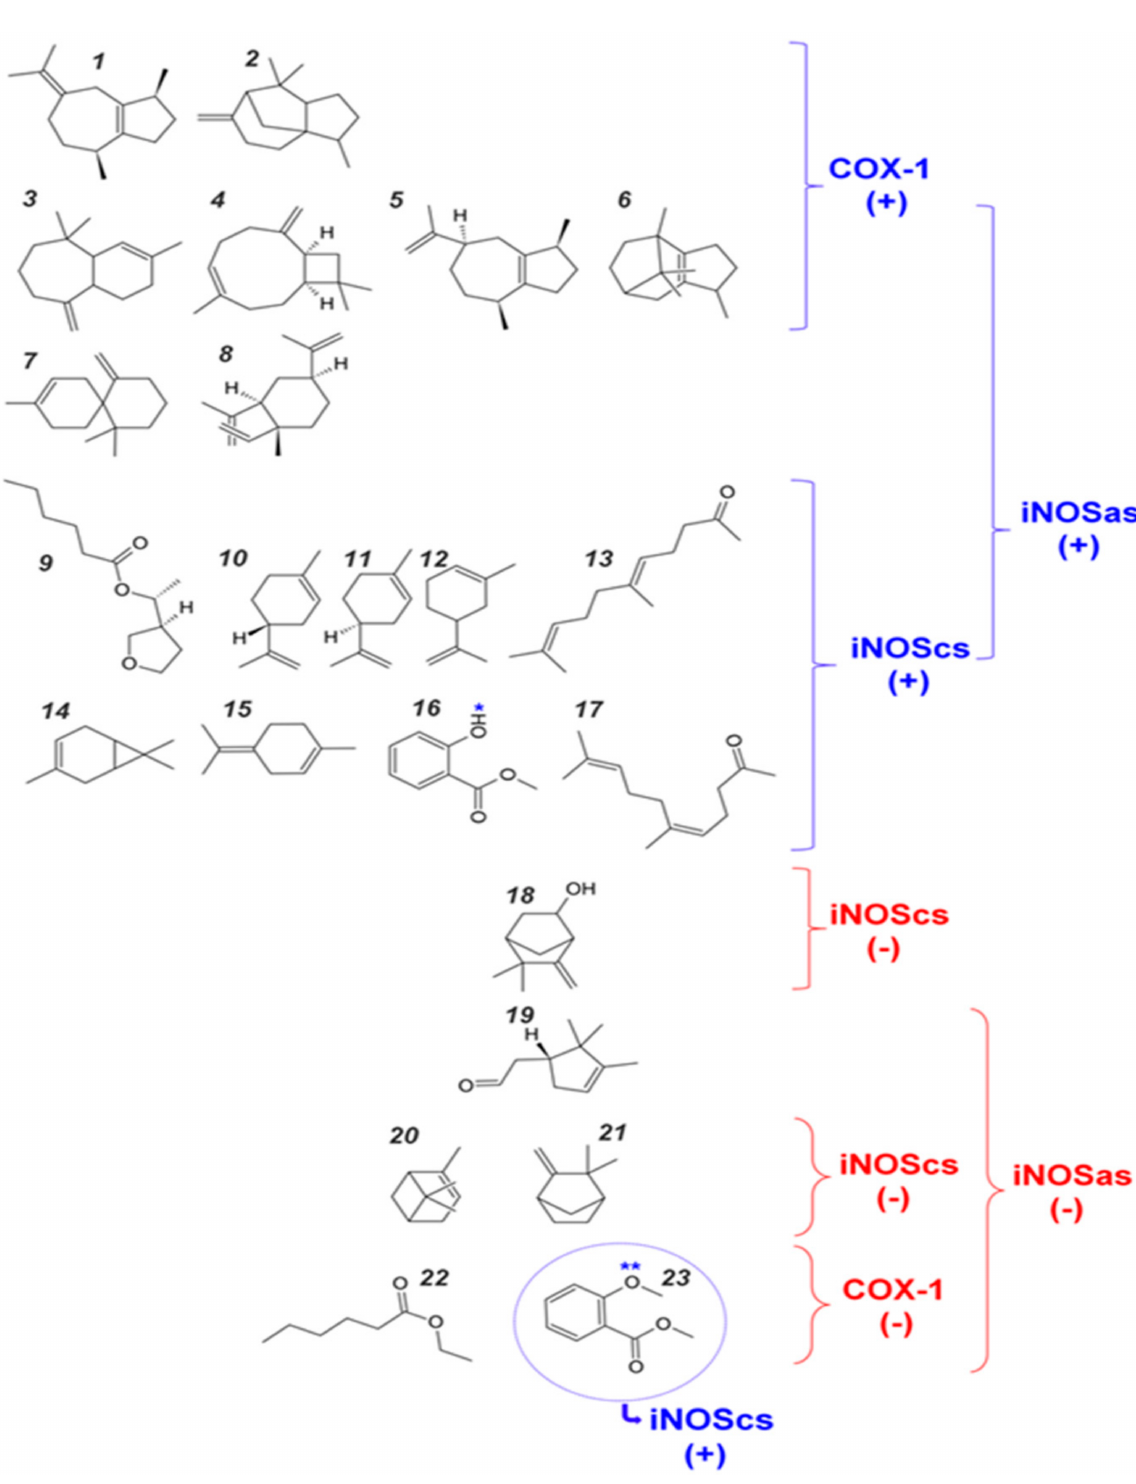
Figure 4. Aroeira compounds and respective classifications according affinities to eachsite. 1 — β -guaiene; 2 —Cedr(8)-15 ene; 3 — α -Himachalene; 4 —Caryophyllene; 5 —Guaia-1(5),11-diene; 6 — Patchoulene; 7 — β -Chamigrene; 8 —Elemene; 9 —Cyclopentylethylhexanoate; 10 —D-Limonene; 11 —p-1,8-diene,(S)(Limonene); 12 —m-Mentha-6,8-diene; 13 —trans-Geranylacetone; 14 —3-Carene; 15 —p-Mentha-1,4(8)–diene; 16 —Salicylic acid, methyl, methylester; 17 —cis-Geranylacetone; 18 — Camphenol,6; 19 — α -Campholenal; 20 — α -Pinene; 21 —Camphene; 22 —Ethylcaproate; 23 —o-Anisic acid, methylester. The two salicylate derivatives (compounds 16 and 23 ), potentially able to suicide inhibition (directly, or after modifications) are highlited with a blue